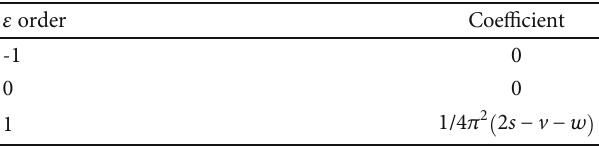
Table 1: A 1 ε series ½ 1, 1 (cid:3) .